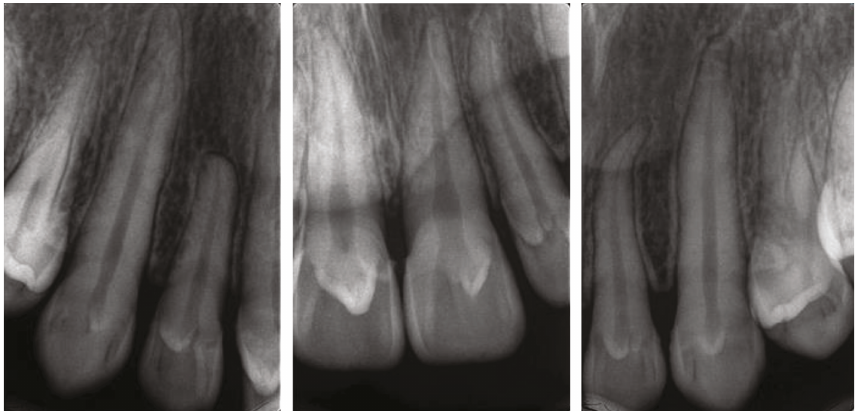
Figure 12: Case 3: periapical radiograph shows radiographic appearance of talon cusps.